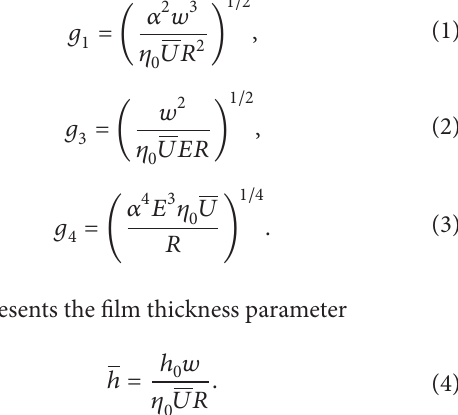
against aer 𝑔𝑔 3 𝑔𝑔 1